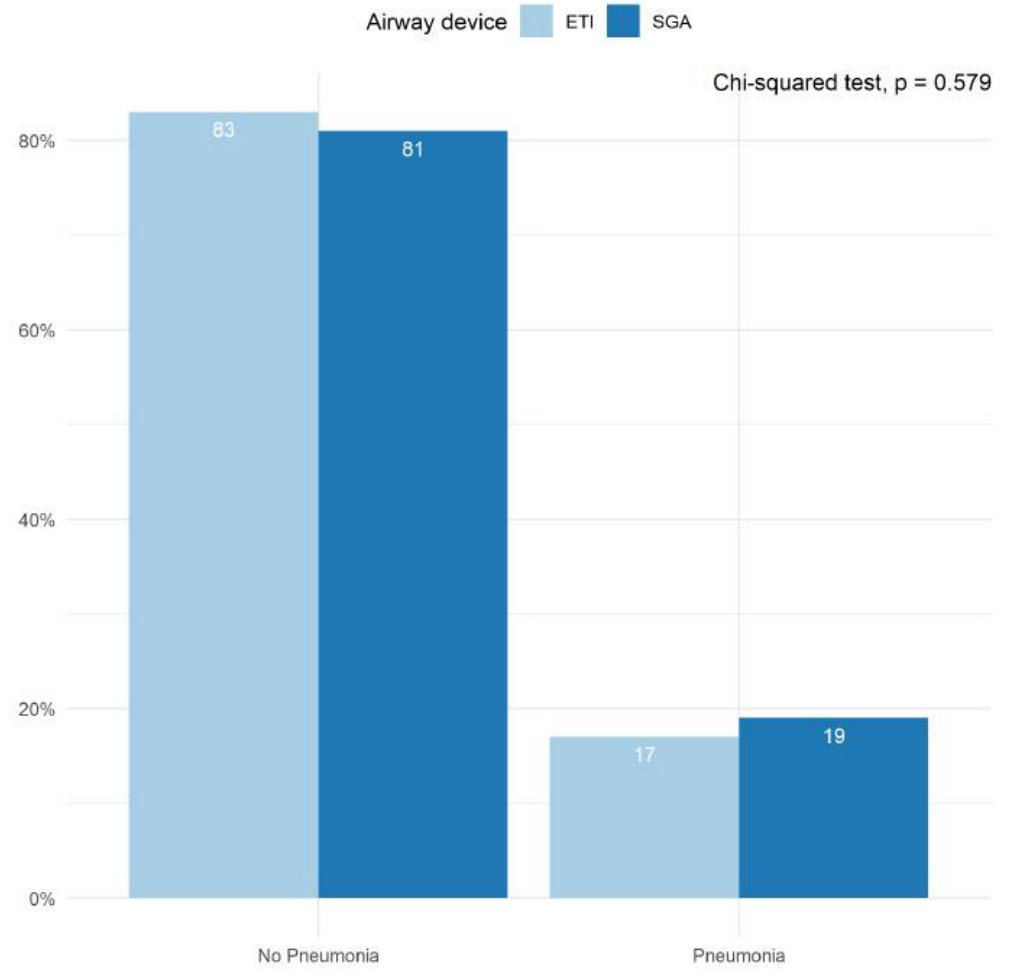
Figure 4. Pneumonia diagnosed during hospital stay. Bar plots depicting the proportion of patients in whom pneumonia was diagnosed prior to hospital discharge. Results are shown for the ETI group and the SGA group separately. The proportions were averaged across all imputed datasets. The Chi-squared test was performed in each imputed dataset and the results were pooled across all available imputed